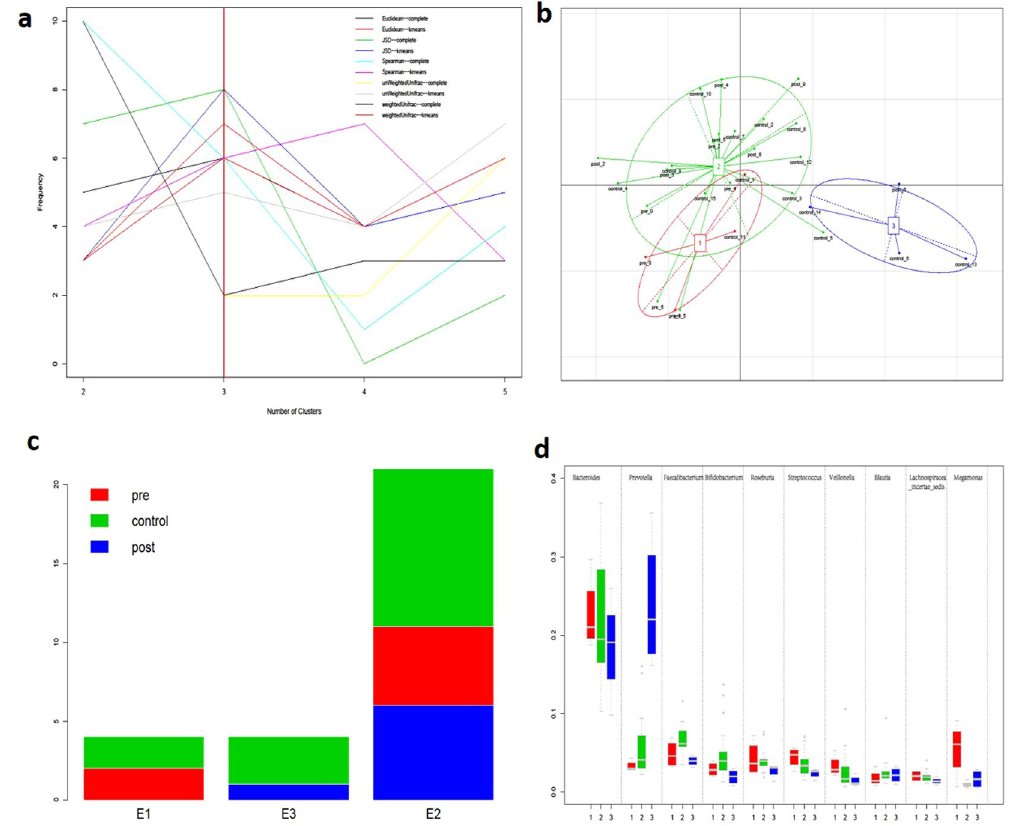
Figure 2. The enterotypes of samples from the pre-LT, post-LT, and healthy control groups were analyzed. ( a ) The number of enterotype clusters. ( b ) The enterotypes of all samples. ( c ) The distribution of enterotypes. ( d ) The genus distribution of all enterotypes.